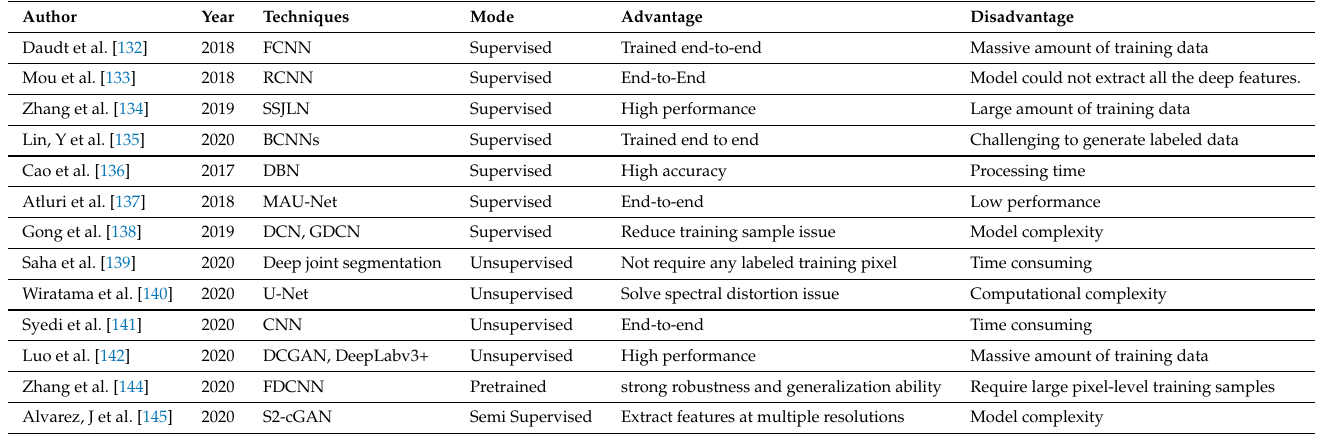
Table 10. Summary of the literature work of change detection techniques based on a multispectral image